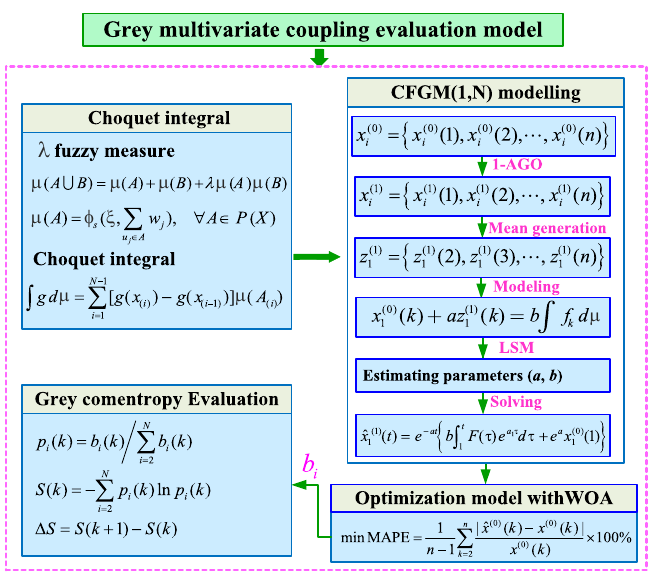
Figure 2. Flow chart of CFGM(1,N) evaluation model